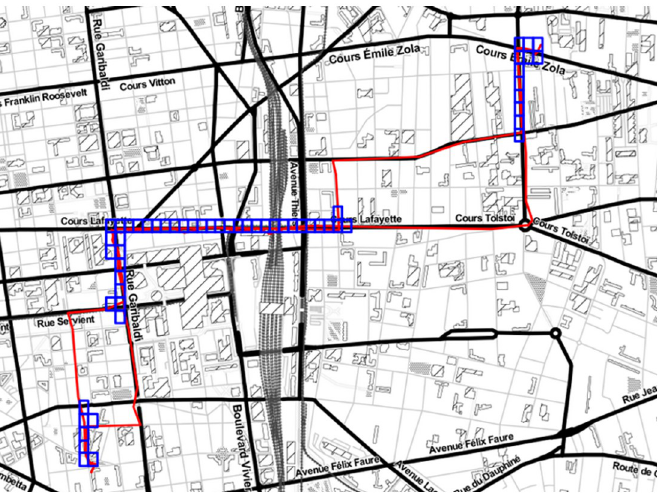
Fig 5. Graphical example of the intersection between the extended sets of cells of two